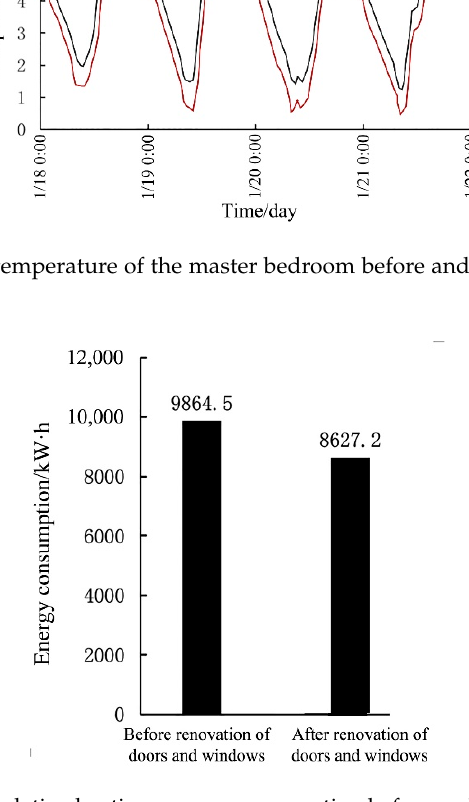
Figure 21. The annual cumulative heating energy consumption before and after renovation of doors and windows. Table 8. The data of temperature and energy consumption before and after renovation of doors and windows.